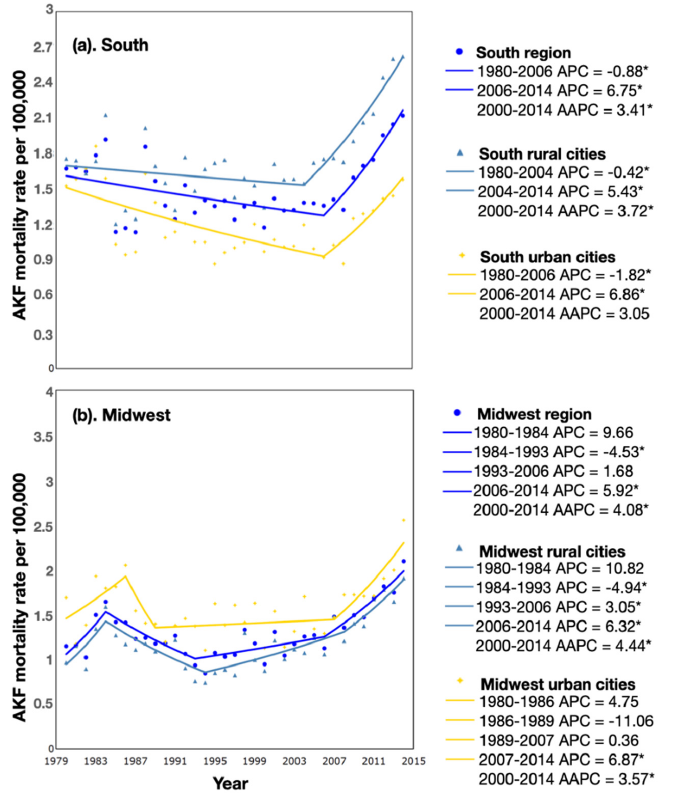
Figure 1. Mortality trends for acute kidney failure, 1980–2014. ( a ) Acute kidney failure mortality crude rates for the south region and its rural and urban municipalities. ( b ) Acute kidney failure mortality crude rates for the midwest region and its rural and urban municipalities. * Significant at p < 0.05.